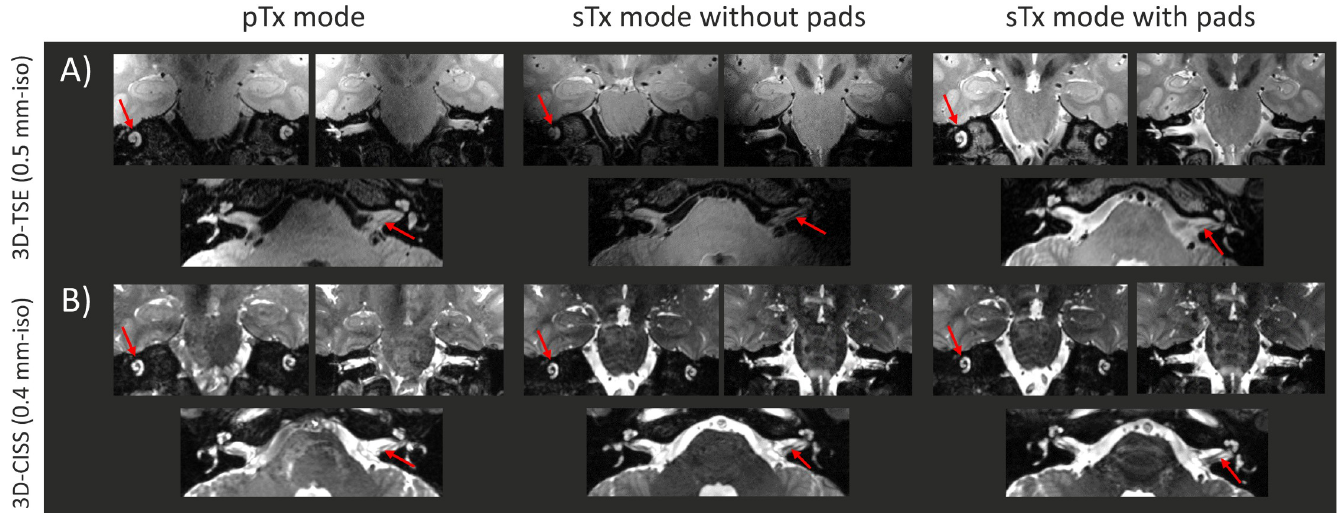
Fig 3. High-resolution MR images of the inner-ears, given for the coil models shown in Fig 1. For parallel-transmit (pTx mode), and single transmit modes with and without dielectric pads (sTx mode without/with pads, respectively): A) high-resolution 3D-TSE (0.5 mm-isotropic) and B) high-resolution 3D-CISS (0.4 mm-isotropic) images shown in two coronal and one transverse slice. The red arrows indicate the structures of interest, namely the cochlea and the auditory nerves. The MR images are shown for a same subject.